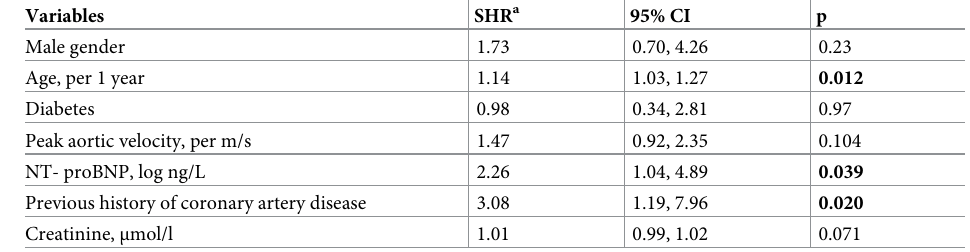
Table 2. Competing risk regression analysis of all-cause mortality in 114 patients with asymptomatic, severe aor- tic stenosis (competing event: Aortic valve replacement during follow-up).